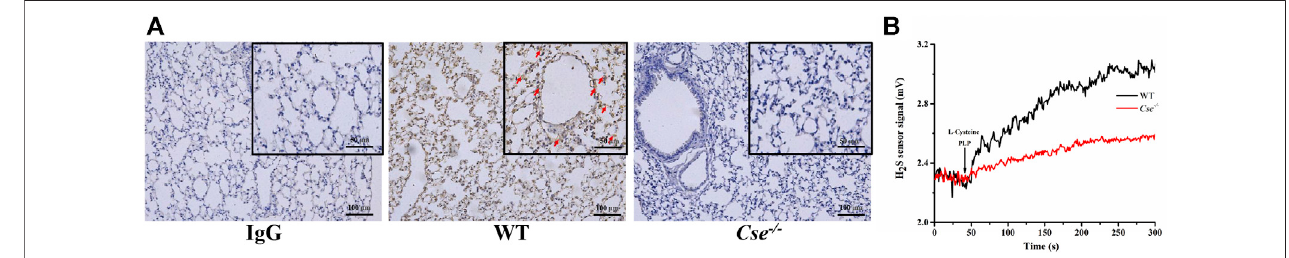
FIGURE 4 | CSE expression localization and H 2 S production in the lung tissue of WT and Cse -/- mice. (A) , CSE expression in lung tissues of WT and Cse -/- mice was analyzed by immunocytochemistry. Representative images of CSE expression in the lung tissue of WT and Cse -/- mice. Arrows indicate CSE positive staining. (B), H 2 S production rate in the lung tissues of WT and Cse -/- mice. Black trace, representative trace of H 2 S production in the homogenate of lung tissue in WT mice. Red trace, representative trace of H 2 S production in the homogenate of lung tissue in Cse -/-